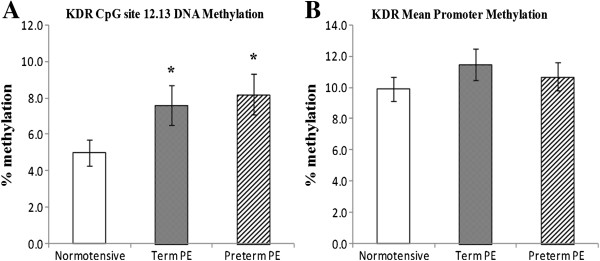
Mean promoter methylation levels and differentially methylated sites in the KDR promoter: (A) KDR CpG site 12.13; (B) KDR Mean Promoter. *P <0.05 and **P <0.01 as compared to normotensive group. PE, preeclampsia.